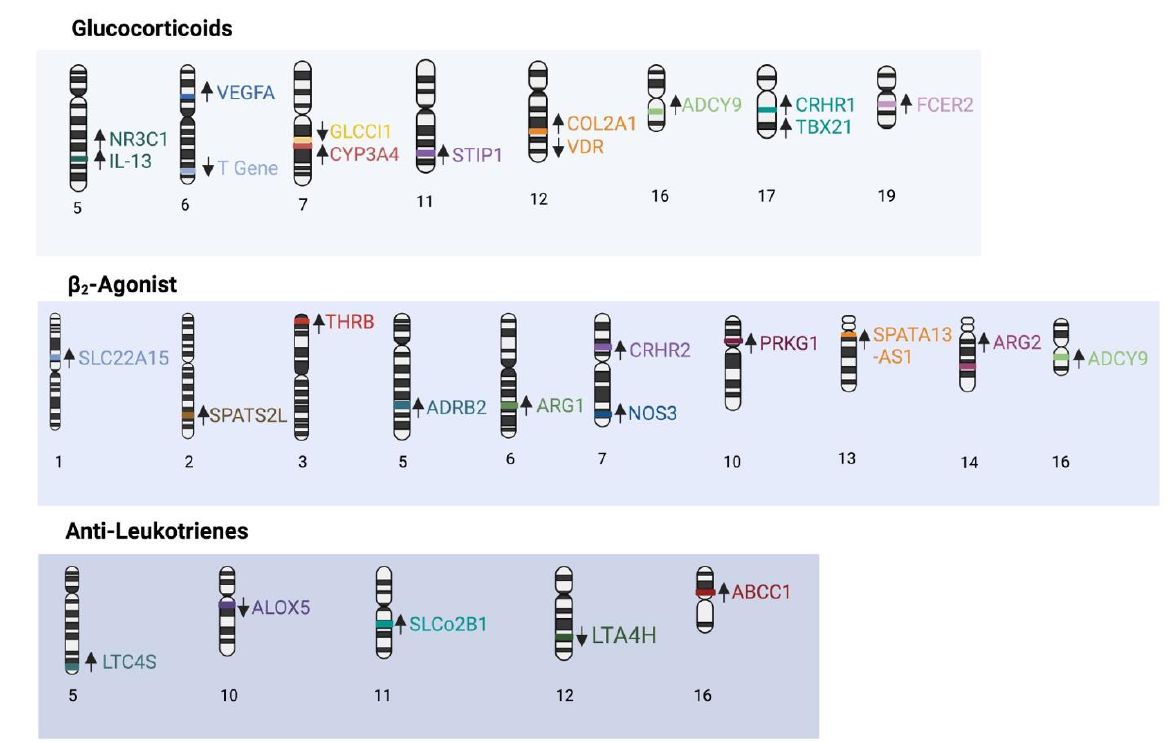
Figure 3. Summary of SNPs associated with treatment response. Arrows indicate improved or worsened response to treatments in the presence of SNPs.